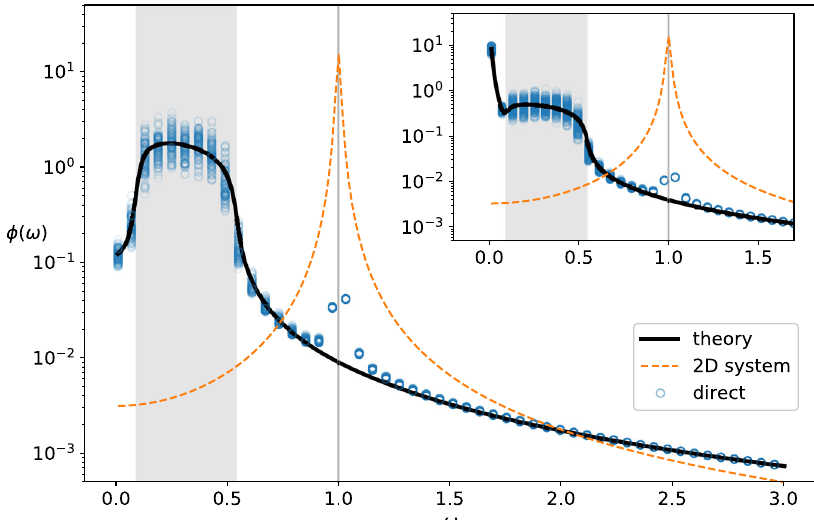
Fig. 4 Fluctuation spectra of bipartite systems. The exact power spectral densities (dots) for predator species in a two trophic level model are computed numerically from Eq. (17), and the corresponding mean power spectral density (solid line) are obtained by solving Eq. (61) (inset shows the prey species). Excited frequencies are con fi ned to a band (shaded) between critical frequences given in Eq. (14). The order 1/ N peak at ω = 1 in the simulation result relates to the high-level bipartite structure. Its location is predicted by a corresponding 2D system, also shown here for comparison (dashed line). Parameters: N x = 100, N y = 200, c x = 20, c y = 10, α = 5, b = 1, d =